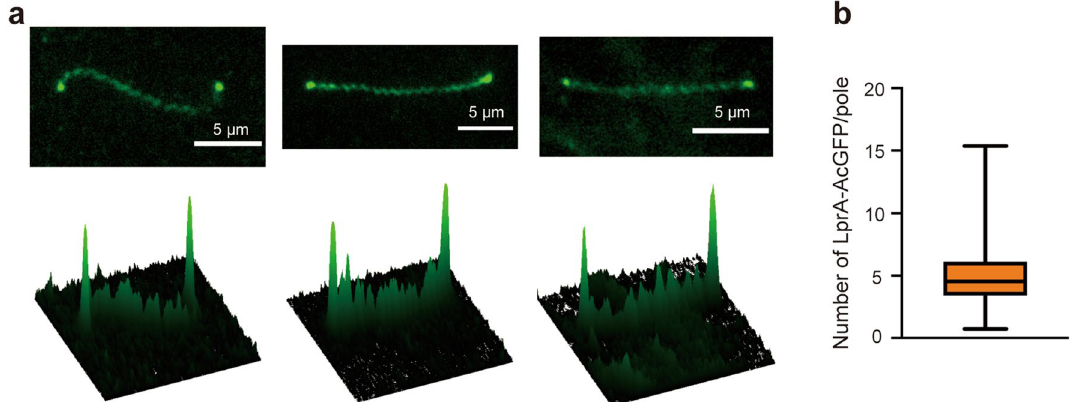
Figure 4. Subcellular localization of LprA. ( a ) Fluorescent images of LprA-AcGFP expressed in the Prd mutant (upper) and 2D intensity profiles (lower). ( b ) Box plot of the number of LprA-AcGFP molecules localized at one end of the cell body. The lower and upper box boundaries are 25th and 75th percentiles, respectively. The line in the middle of the box shows the median number. The lower and upper error lines indicate the smallest and largest values, respectively. 46 cell poles were